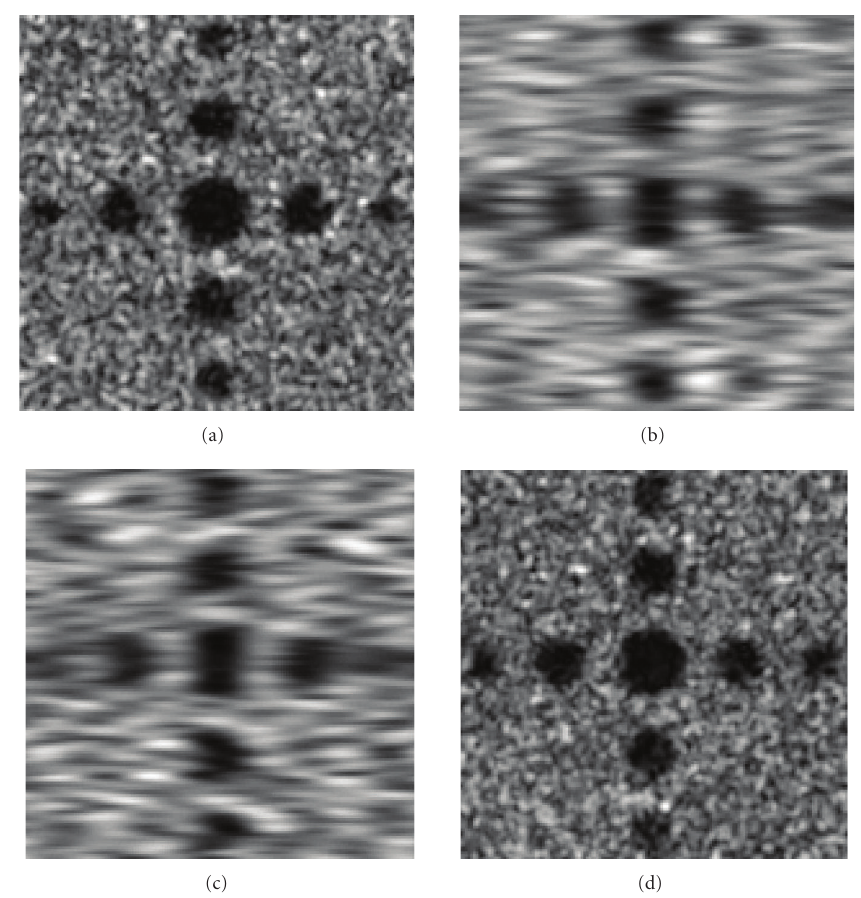
Figure 7: Two reconstructed 3D ultrasound image sets: (a) J 1 cross-sectional view, (b) J 1 sagittal view, (c) J 2 cross-sectional view, (d) J 2 sagittal